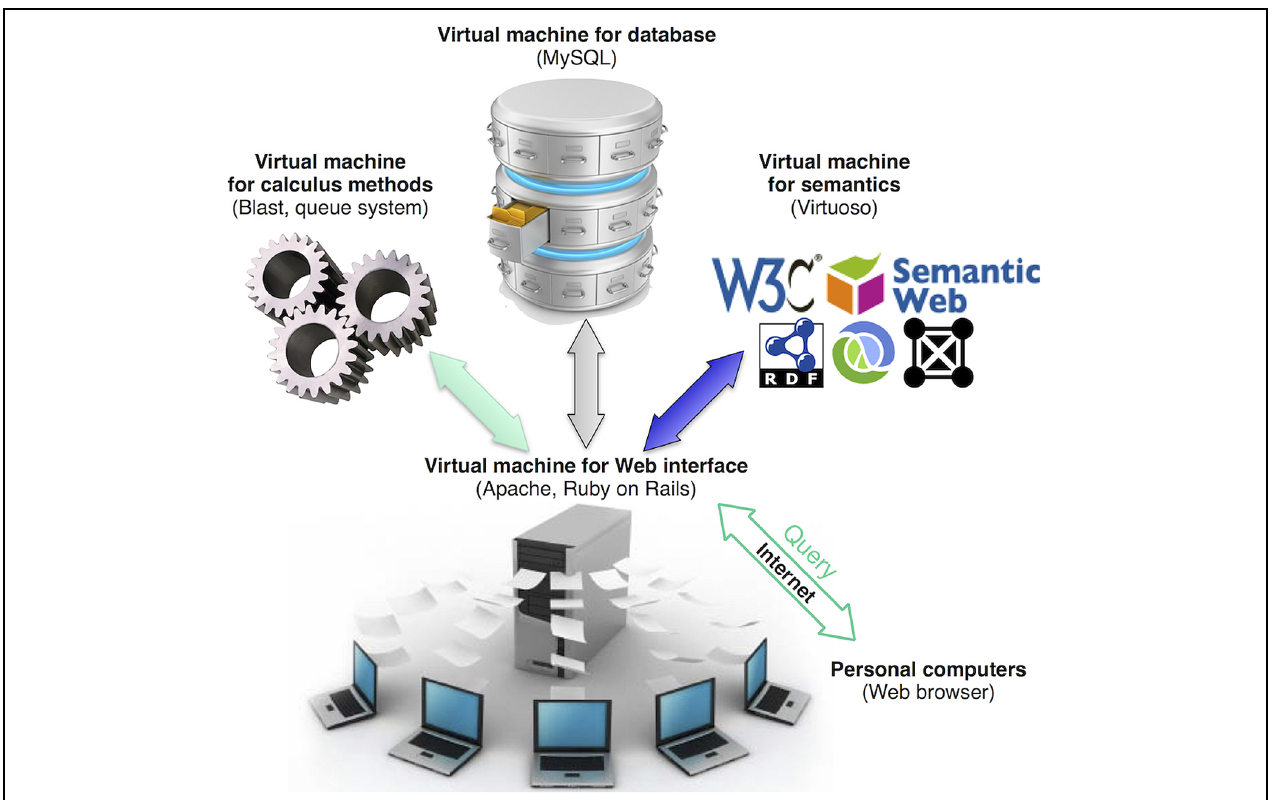
FIGURE 1 | Database organization in virtual machines. Using Web browsers, users will retrieve data from ReprOlive by querying or browsing through the Web interface. Web pages are generated on demand by the virtual machine that manages the Web interface. When queries require intensive